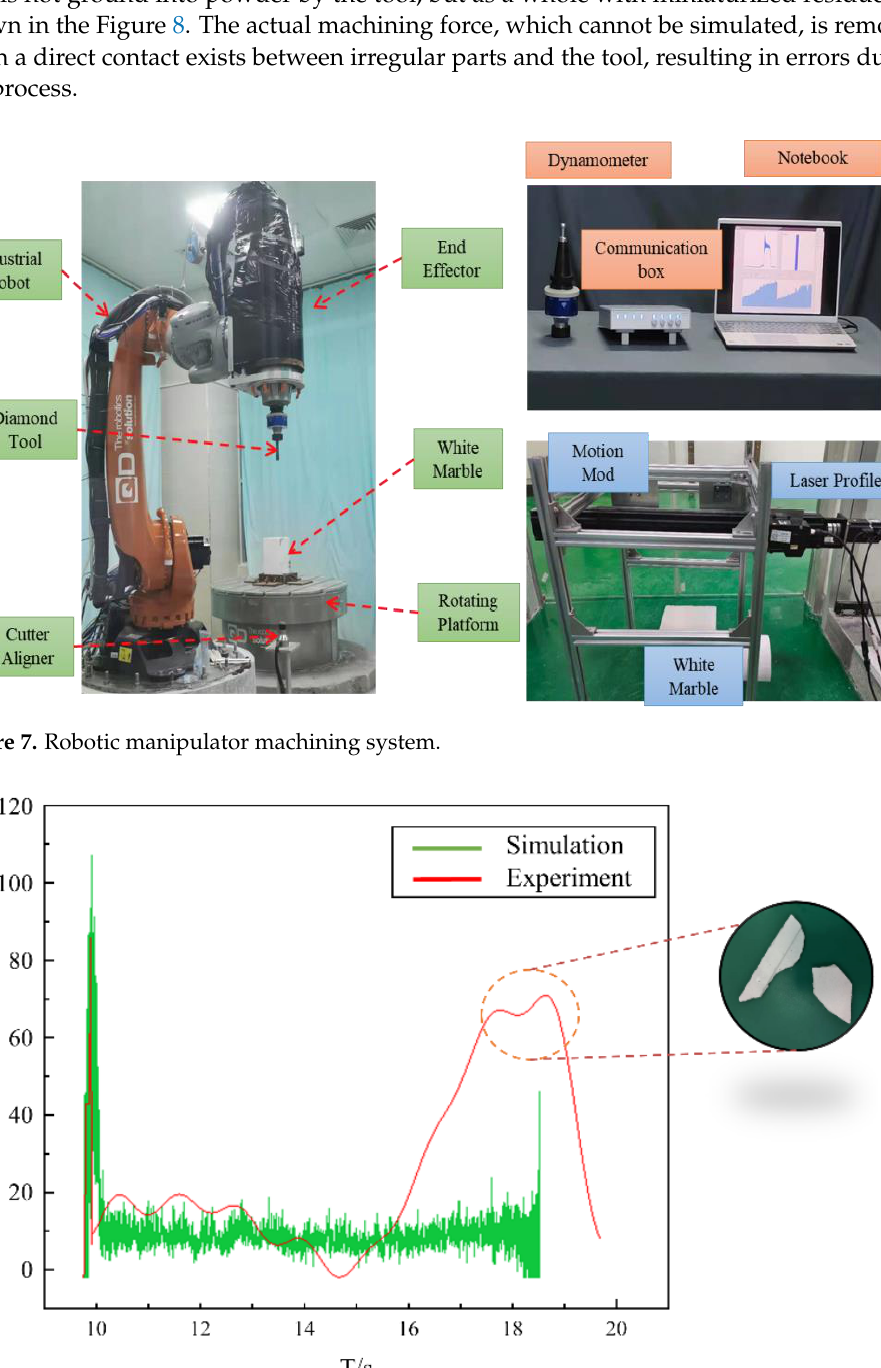
Figure 8. Surface finishing simulation and experiment comparison chart. Table 2. Simulation and experiment comparison table.